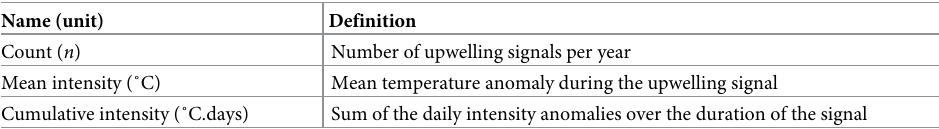
Table 1. Metrics of upwelling signals and their